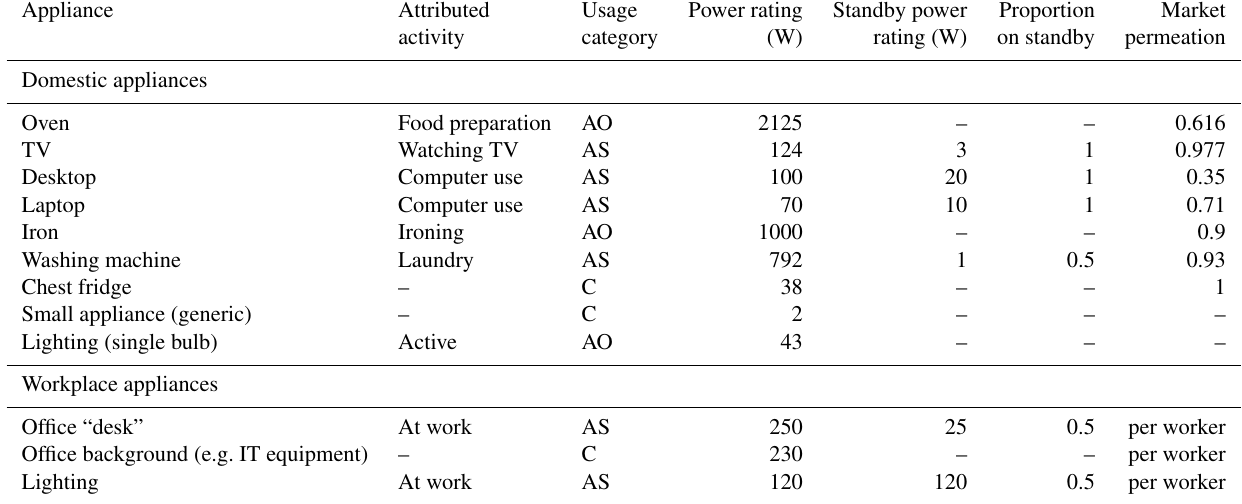
Table C1. Appliances used in domestic and workplace subareas and their attributes. Usage categories: active only (AO) consume energy as a result of user activities; active with standby (AS) consume less when not in active use (standby); continuous (C) have constant power consumption independent of human activity (cycling appliance power converted to continuous). See Table 3 for